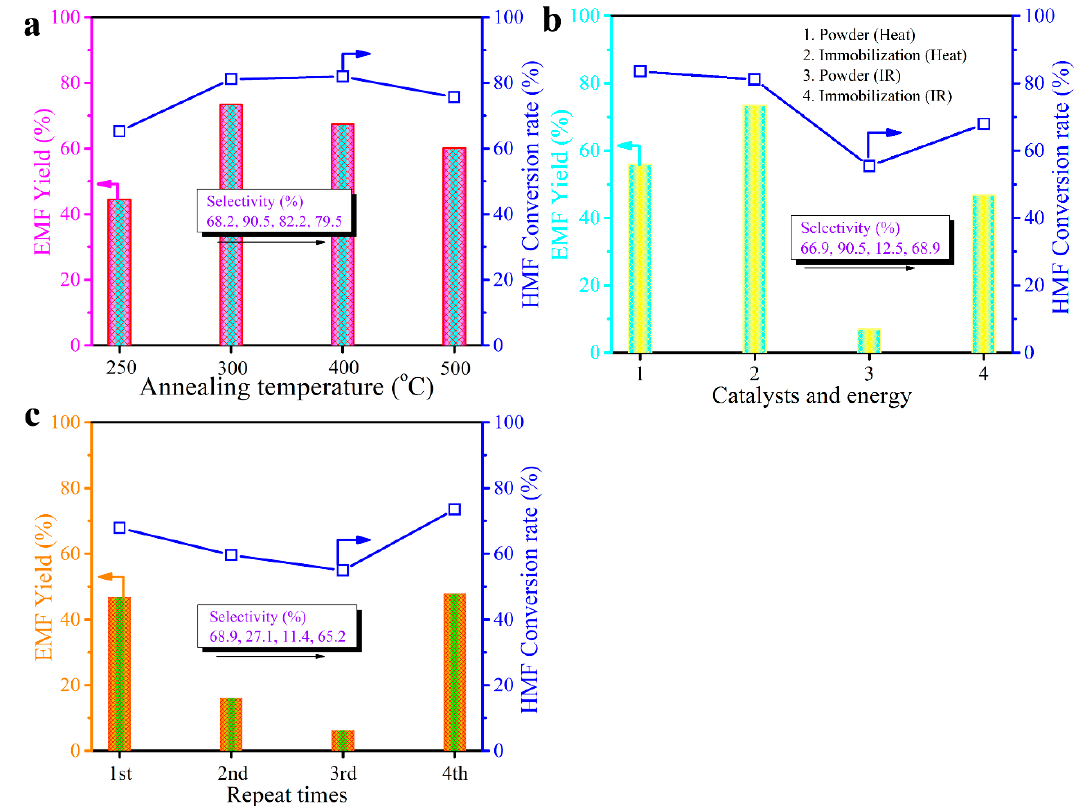
Figure 7. ( a ) Effects of post calcination temperature during the immobilization process of BCQDs/UiO-66-NH 2 on ceramsite on the catalytic activity; ( b ) acid catalytic performance of H + /BCQDs/UiO-66-NH 2 @ceramsite under different heat conditions; ( c ) stability tests by using 4 consecutive catalytic etherification reactions of HMF to EMF.